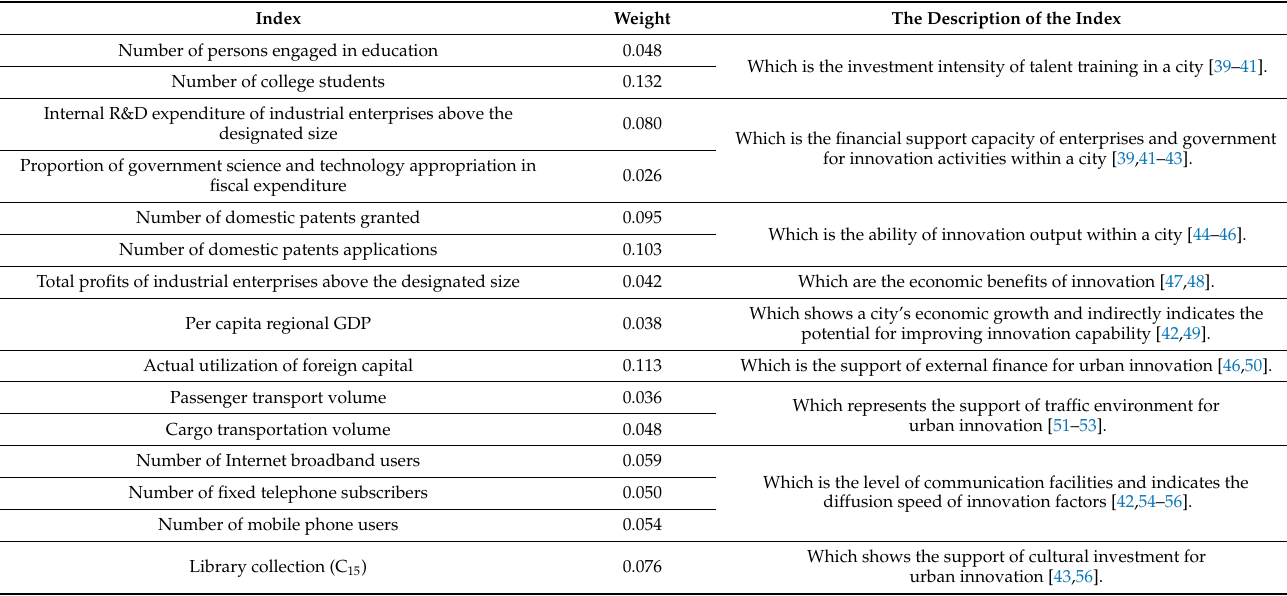
Figure 1. Study area: ( a ) Location of Jiangxi Province, Hunan Province, and Hubei Province in China. ( b ) Location of UAMRYR in three provinces. ( c ) Cities included in UAMRYR. Table 1. Innovation ability evaluation